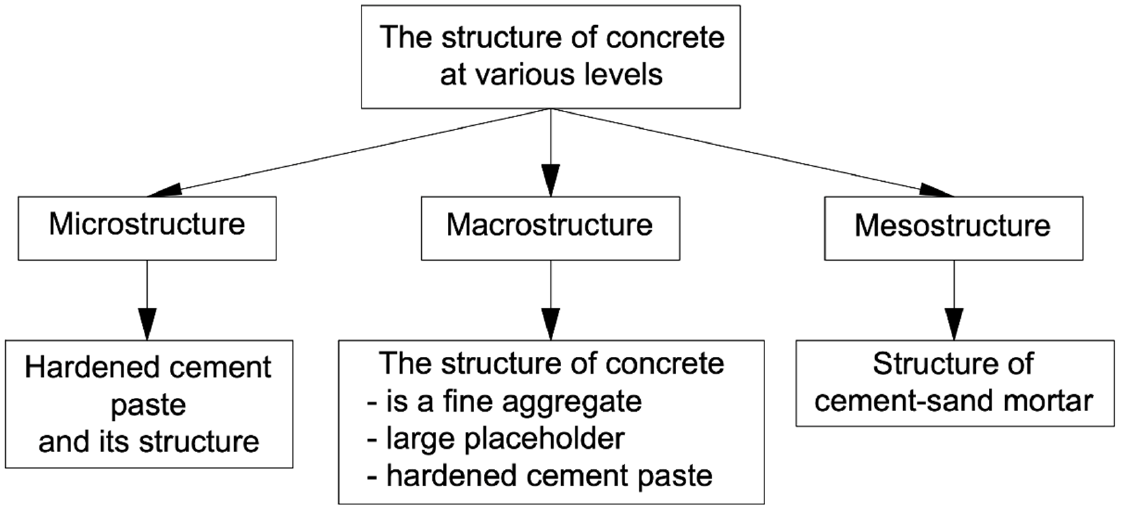
Figure 11. Structure of concrete at different levels.